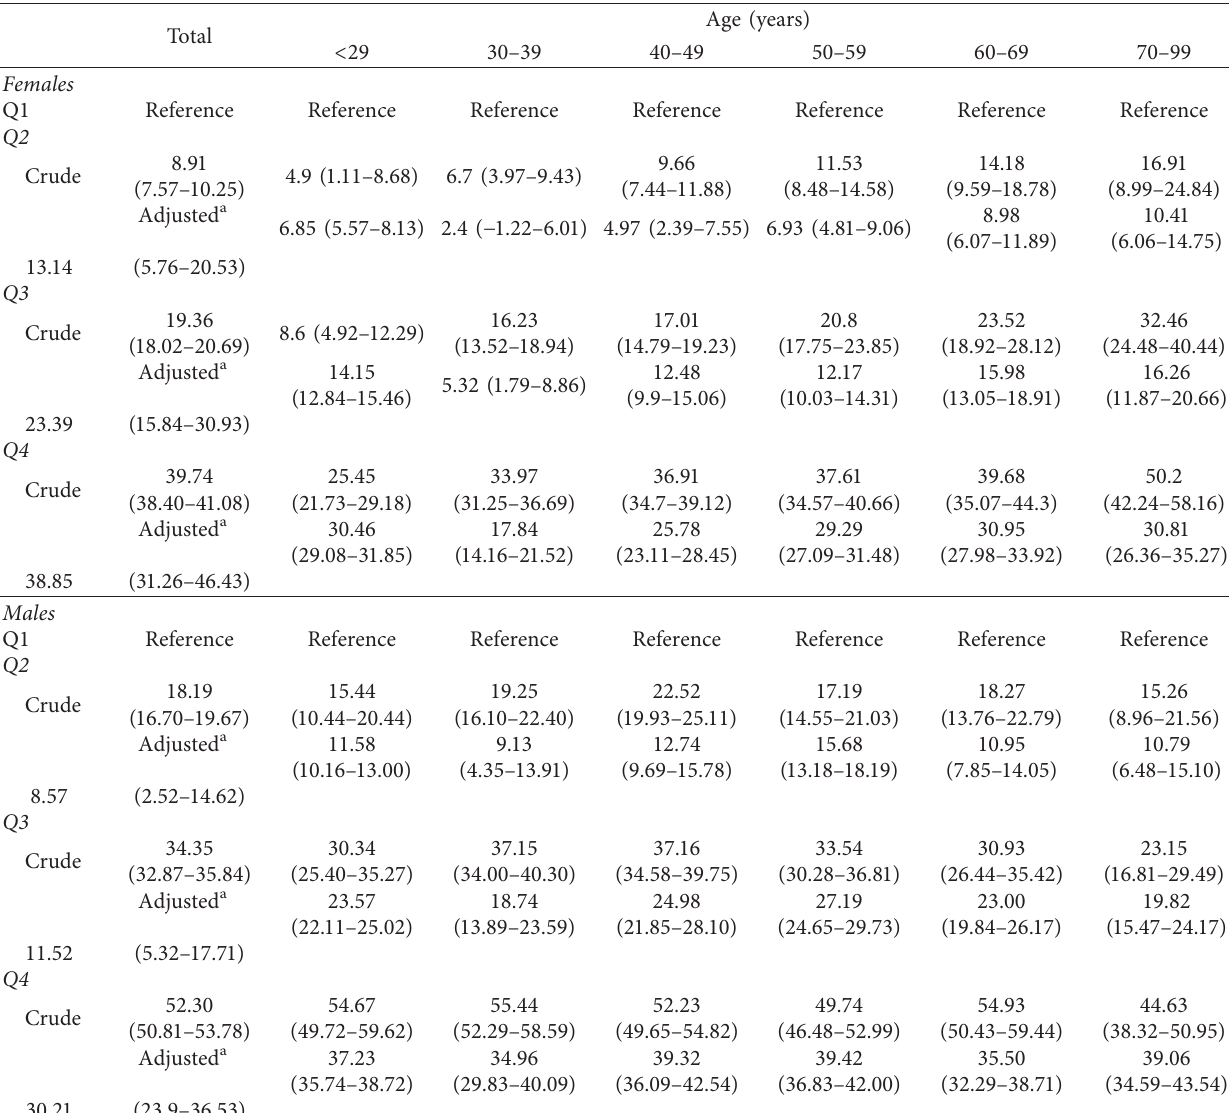
Table 2: Sex-and age-stratified differences (95% confidence intervals) in serum urate levels ( μ mol/L) according to serum triglycerides